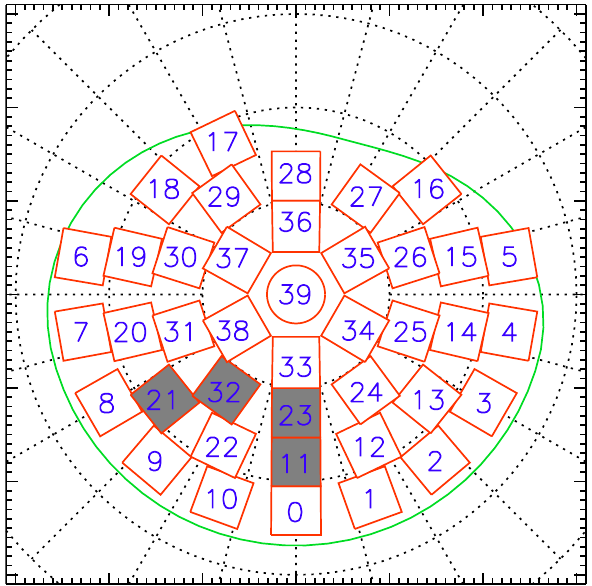
Fig. 2. The locations of the statistical data points used in the reduced SuperDARN database, plotted on a polar grid in magnetic local time – magnetic latitude coordinates with noon to the top and dusk to the left. The data points are located at the centre of the red boxes which themselves delimit the area in which local data coverage is defined. The latitudes of the boxes is shown on an arbitrary scale, being dependent on the location of the zero potential boundary, 3 0 , (shown in green) in each case. Data from the shaded boxes are discusses in the